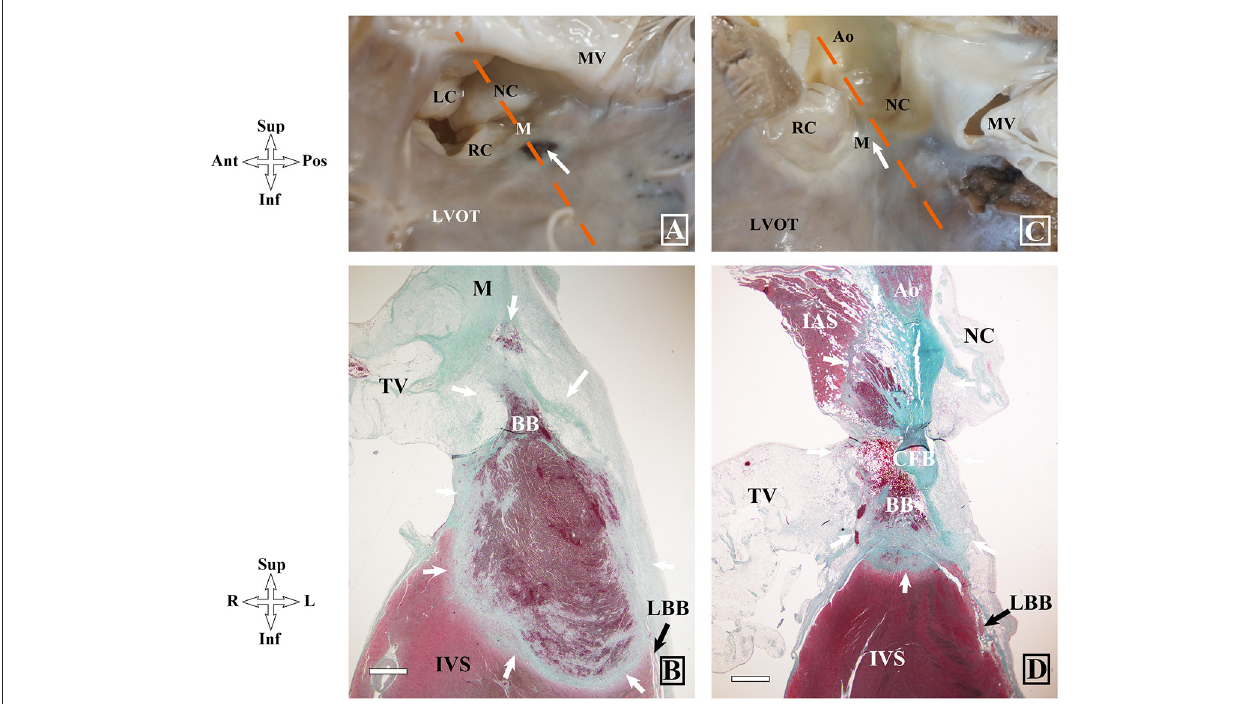
FIGURE 5 | Gross and histopathologic images of different locations of ablation lesions and related injuries on atrioventricular conduction system in dog hearts after radiofrequency delivery. (A,B) Coagulative necrosis is shown at the left upper septum below the IMS in dog #5 (group1). (C,D) Complete necrosis in the IMS in dog #2 (group2). BB, bundle branch; IMS, interventricular membranous septum; LAF, left anterior fascicle; LBB, left bundle branch; PB, penetrating bundle; RBB, right bundle branch; RC, right coronary leaflet; LC, left coronary